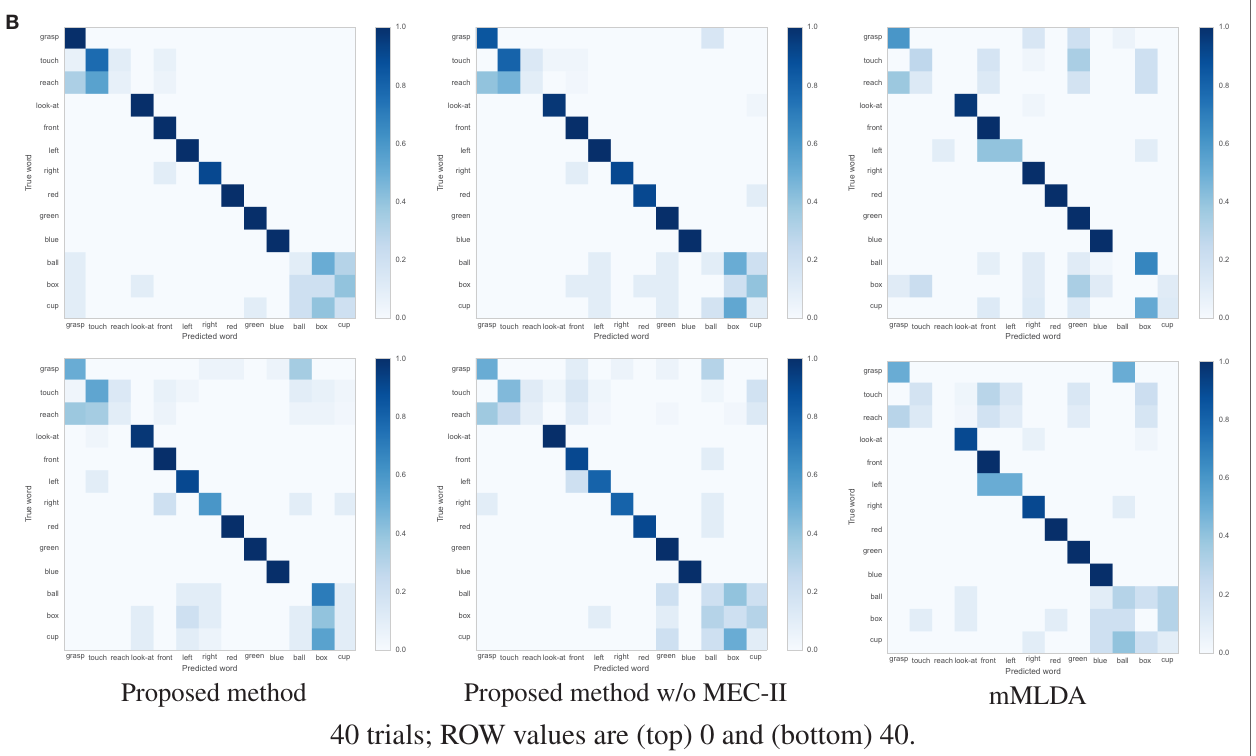
Frontiers in Neurorobotics |